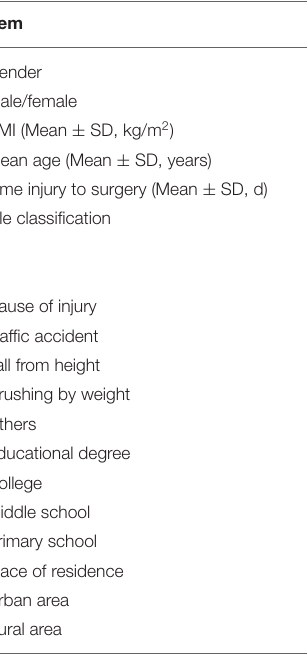
TABLE 1 | Clinical data ( n =